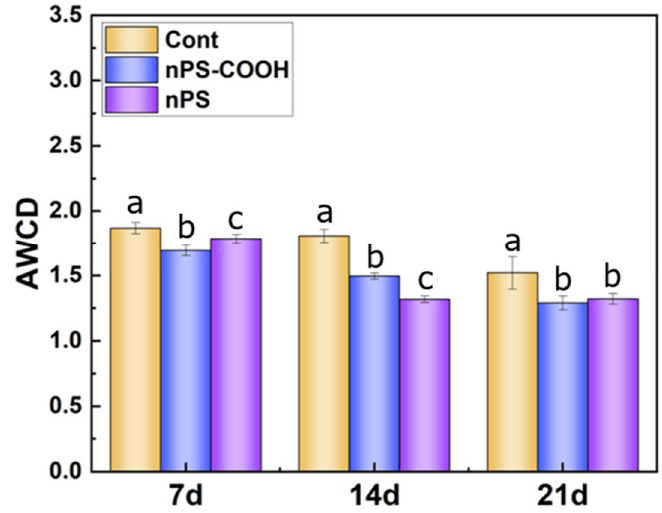
Figure 2. Total carbon metabolism capacity of biofilms (fitted by Equation (2) at the stable stage) exposed to PS NPs with different surface modifications at day 7, day 14, and day 21 ( n = 3). Different letters represent significant differences among the PS treatments ( p < 0.05).